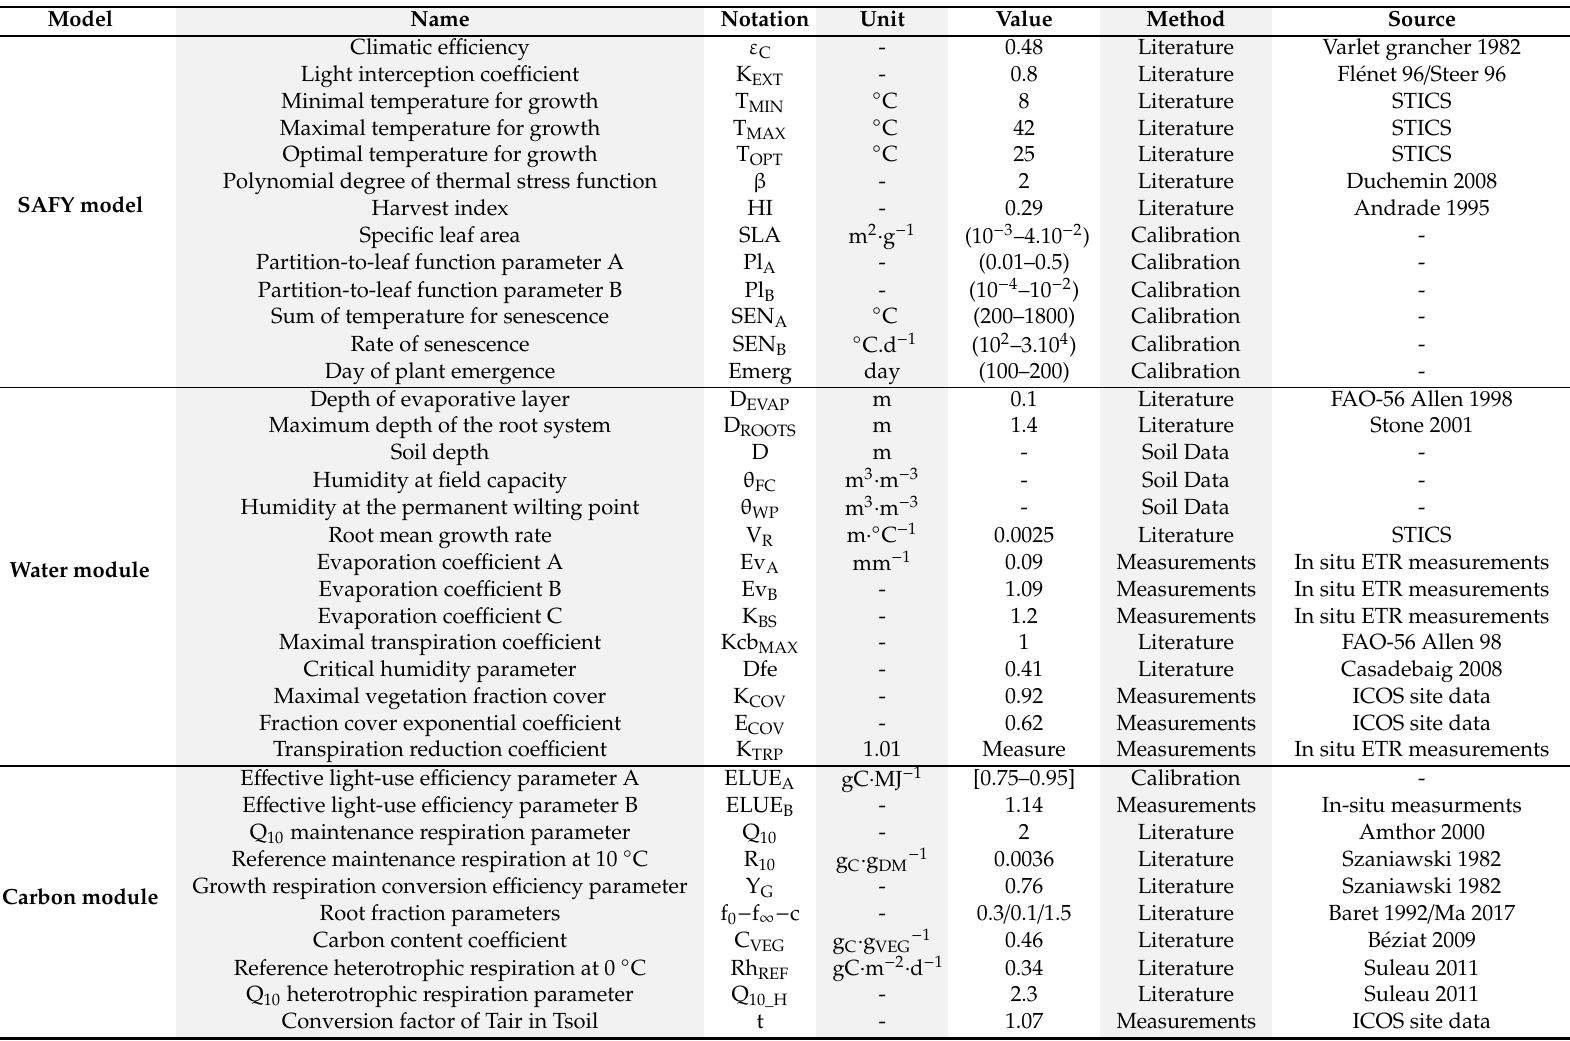
Table 5. List of the SAFYE-CO 2 model parameters for sunflower, values, or a priori intervals of the parameters, method for setting them, and relevant